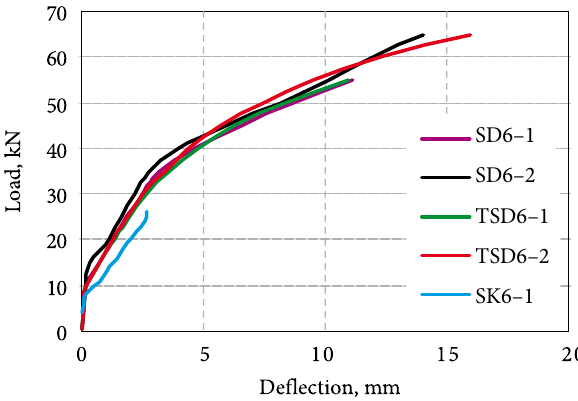
Fig. 9. Experimental (SD6) and theoretical (TSD6) deflections of beams and experimental deflection of control beam